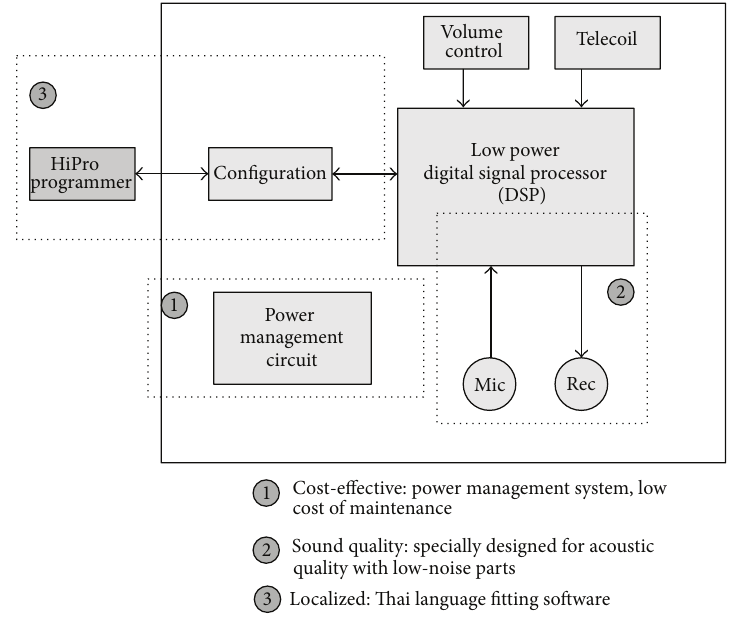
Figure 2: PDN-01B functional block diagram.